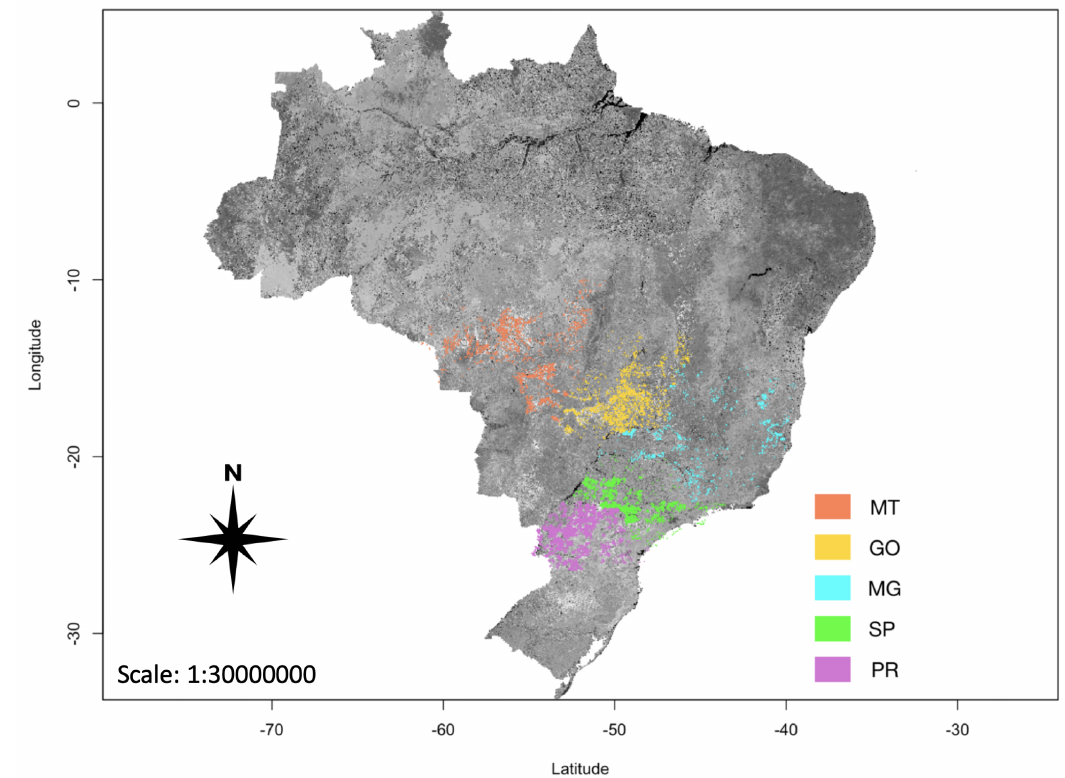
Figure 7. Country view without geopolitical